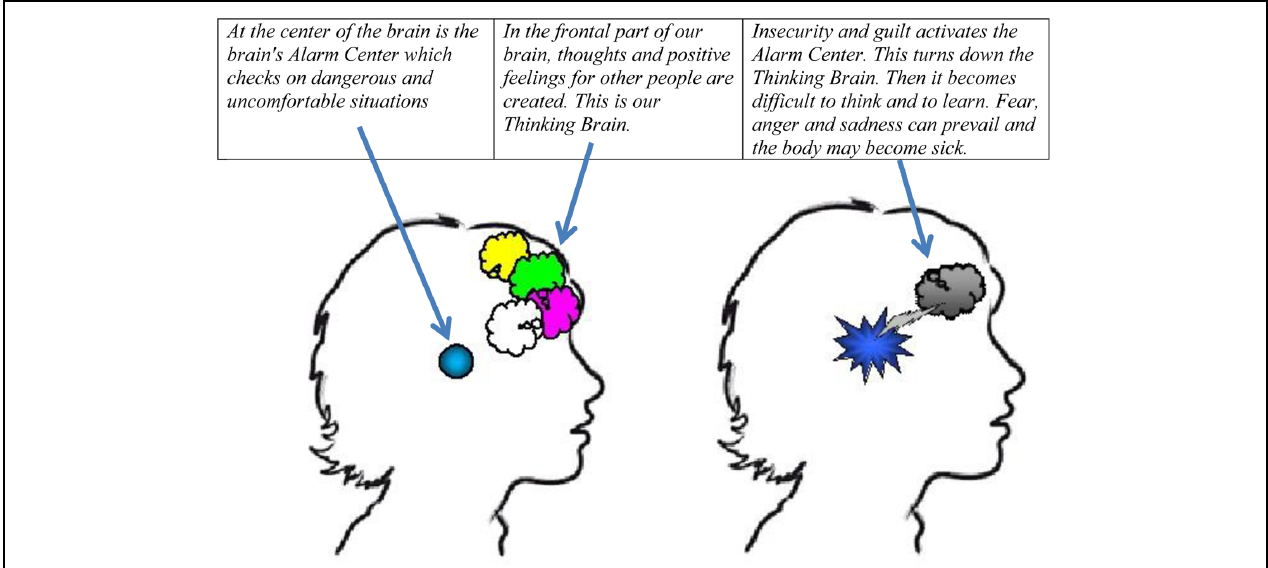
FIGURE 1 | Picture from the Resilience Program describing “the Thinking Brain” and the “Alarm